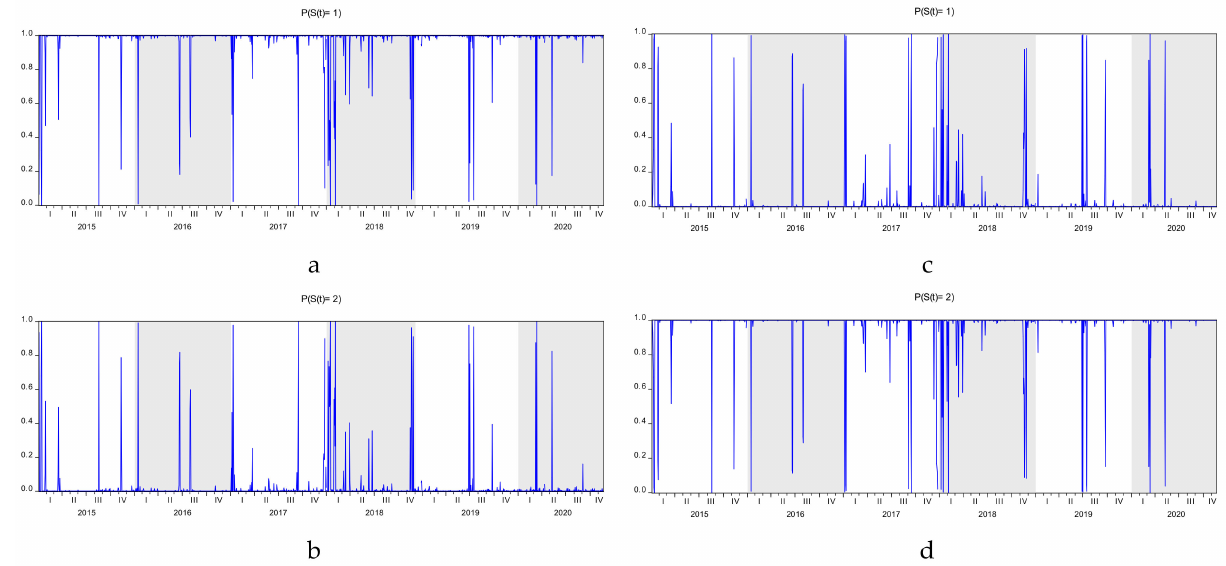
Figure 2. Markov Switching Smoothed Regime Probabilities. ( a , b ) indicate the regime one and regime two probabilities of yuan’s model whereas ( c , d ) depict the regime one and regime two probabilities of rupee’s model,